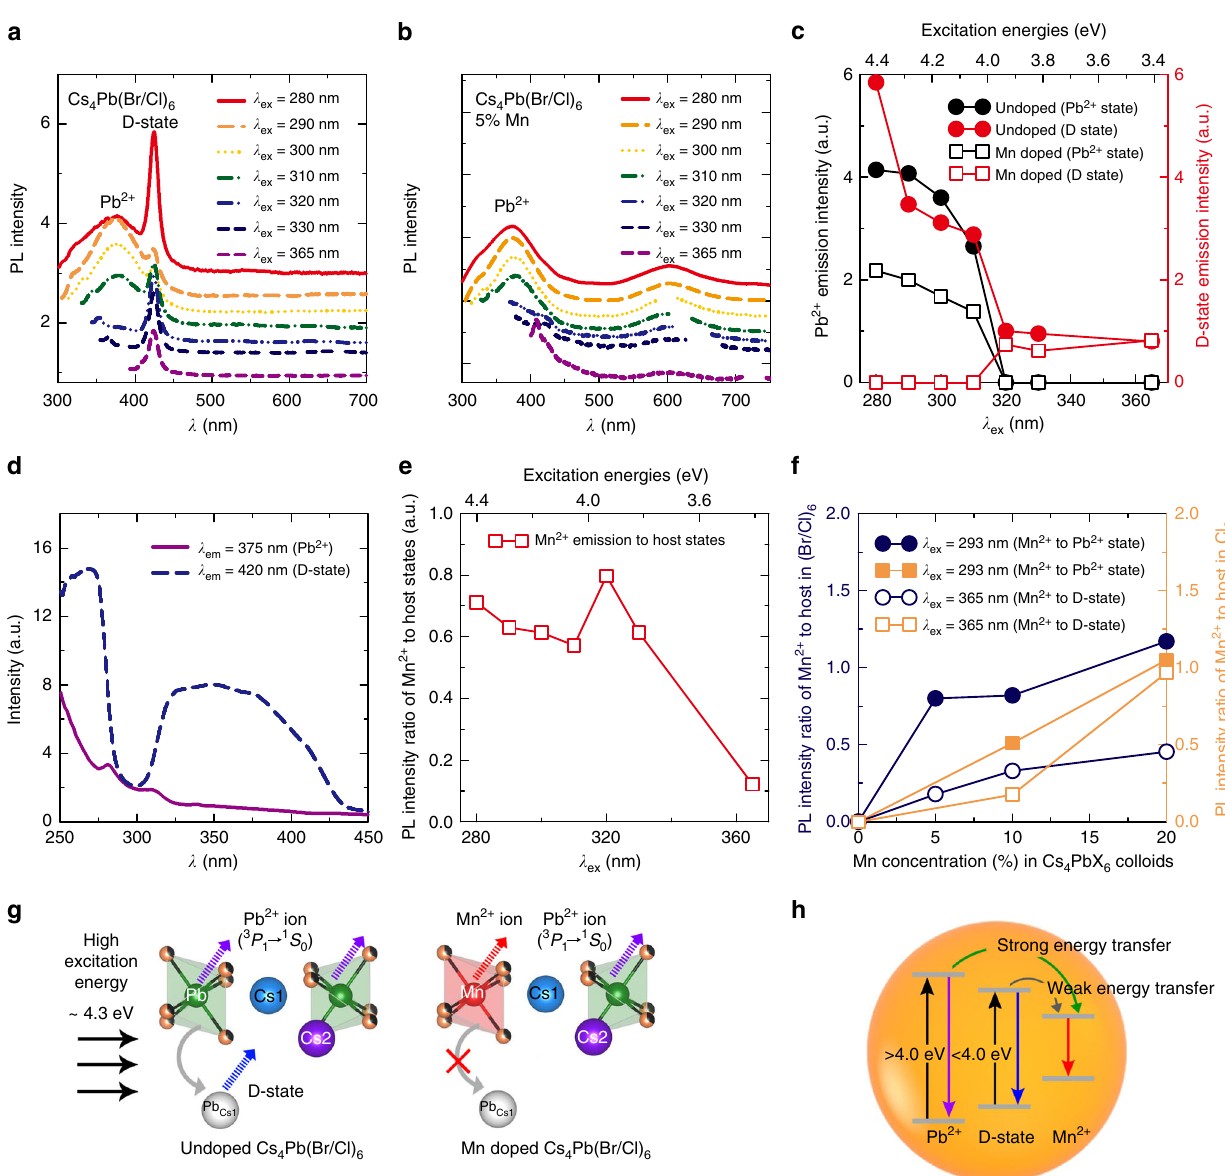
Fig. 3 Probing the host states at the isolated octahedron with Mn 2 + ion. Colloidal PL spectra measured at different excitation wavelengths ranging 280 to 365 nm for the a undoped Cs 4 Pb(Br/Cl) 6 and b Cs 4 Pb(Br/Cl) 6 :5% Mn. c Emission intensities of Pb 2 + and D-state emission with varying excitation energies for the undoped and Mn-doped Cs 4 Pb(Br/Cl) 6 :5% Mn, d excitation spectra of Cs 4 Pb(Br/Cl) 6 :5% Mn colloids by monitoring at 375 nm (Pb 2 + ion), and 420 nm (D-state), e PL intensity ratio of Mn 2 + to the host emission with respect to varying excitation energies, f PL intensity ratio of Mn 2 + to the host states with varying Mn concentration for Cs 4 PbX 6 colloids, where X = (Br/Cl) and Cl, g origin of host emissions namely Pb 2 + and D-state under high excitation energies, without and with Mn doping at high excitation energies. The solid, dashed, and curved arrows are denoted for optical excitation, emission, and energy transfer processes, respectively. h Strength of energy transfer from the host states namely Pb 2 + and D-state to the Mn 2 + emission are depicted. The upward, downward, and curved arrows are denoted for the optical excitation, emission, and energy transfer processes,